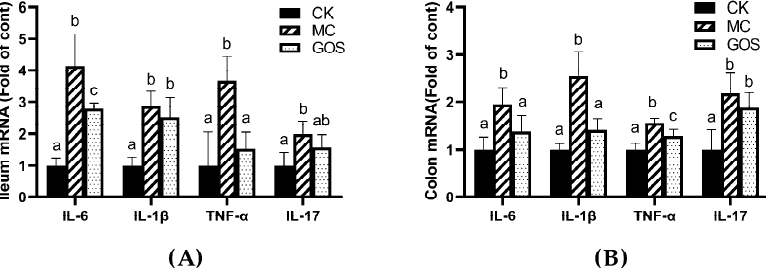
Figure 4 . Relative mRNA levels of inflammatory factors, all normalized to β -actin mRNA expression. ( A ) Inflammatory factors in ileum; ( B ) Inflammatory factors in the colon. Different letters (a–c) are used to express the significant differences ( p < 0.05) of the same factor among groups.